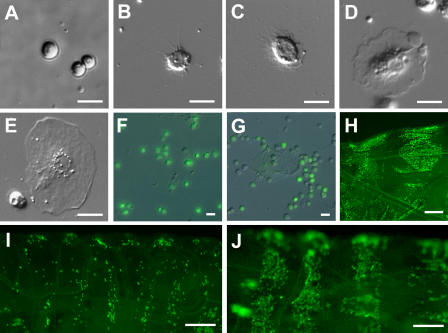
Hemocyte Abnormalities in adgf-a Mutant Larvae(A–E) Differential interference contrast microscopy of living circulating hemocytes (magnification 200×; scale bar, 10 μm). Round, nonadhesive plasmatocytes from wild-type larva (A). Hemocytes from the adgf-a mutant developing filamentous extensions (B and C) or membranous extension surrounding the cell (D). Large flat lamellocyte from the adgf-a mutant (E).(F and G) Differential interference contrast and fluorescent microscopy (merged image) of living circulating hemocytes stained by the Hml-GFP marker (magnification 100×; scale bar, 10 μm). While most of the cells from wild-type larvae are GFP-positive (F), just few of the cells from late third instar adgf-a larvae are stained by GFP at this stage (G).(H–J) Fluorescence microscopy of living larvae with Hml-GFP stained hemocytes (magnification 40×; scale bar, 100 μm). Posterior part of late third-instar wild-type larva (H). Middle sections of early third-instar larvae of wild type (I) and adgf-a mutant (J).